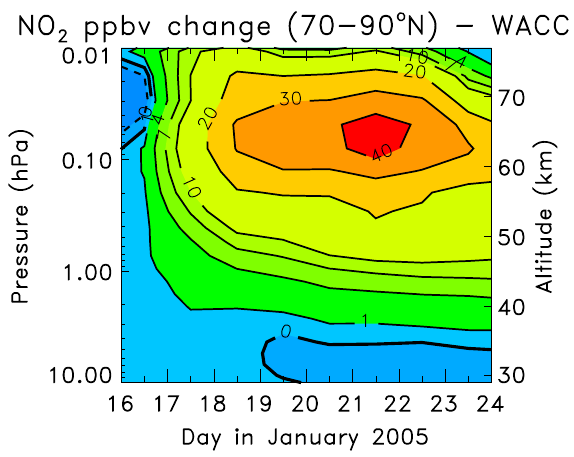
Fig. 10. Daily averaged WACCM3 B average of NO 2 change from the four-day (10–13 January 2005) mean for the 70 ◦ –90 ◦ N band. The contour intervals are − 1, 0, 1, 4, 7, 10, 20, 30, and